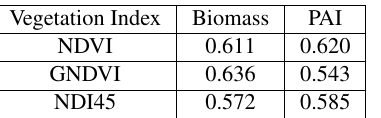
Figure 7. Spatio-Temporal changes of GNDVI in study area.